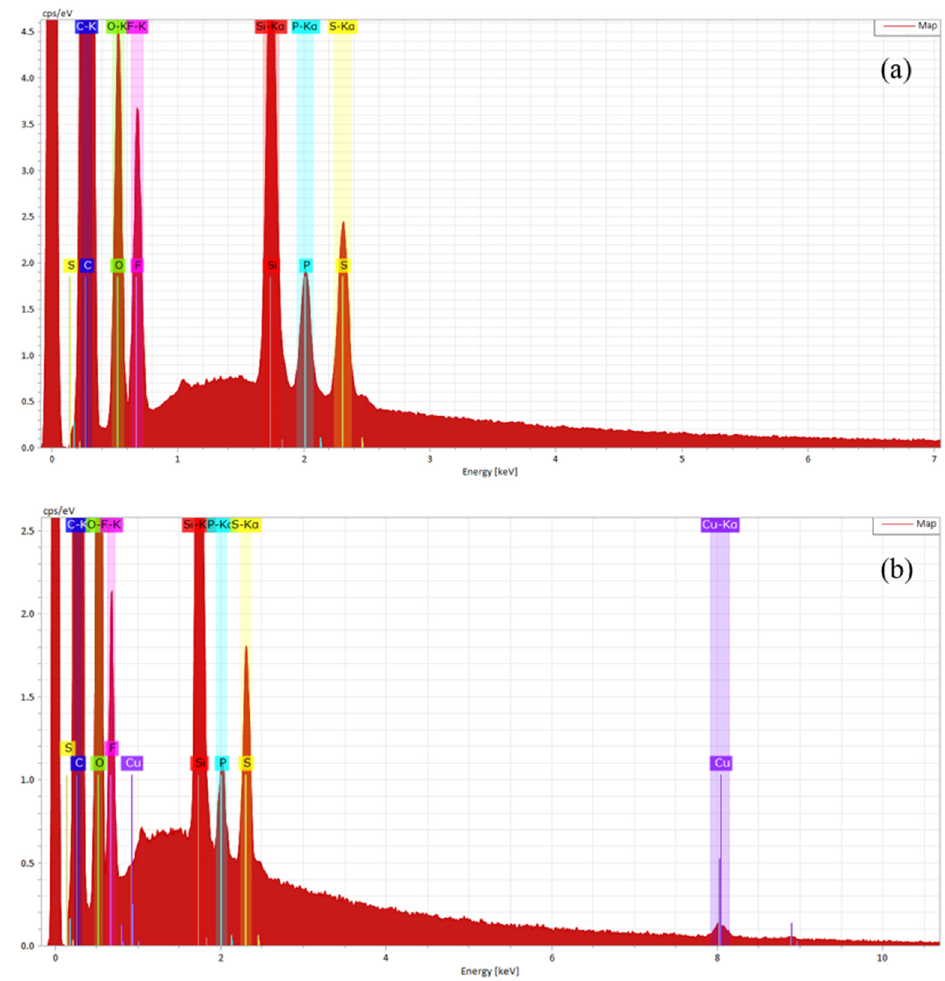
Figure A6. EDX spectroscopy of cells. ( a ) New anode; ( b ) cold aged anode cycled at 1 C and 0 °C.